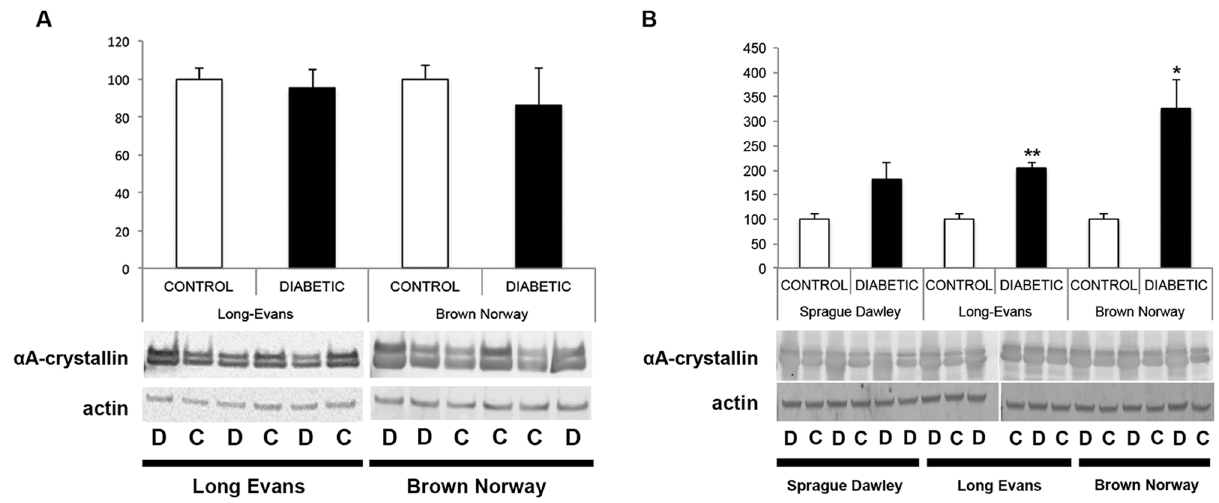
Figure 4. Protein expression analysis of alphaA-crystallin during diabetes. Expression levels were assessed with Western blot analysis using specific antibodies raised against alphaA-crystallin proteins 4 weeks after the onset of diabetes (A) in Long Evans (LE) and Brown Norway (BN) rats. Expression levels were also assessed at 12 weeks (B) in Sprague Dawley (SD), in Long Evans (LE) and Brown Norway (BN) rats. Representative immunoblots and graphic representation of the corresponding quantification of the major bands are presented. C, control; D, diabetic. *Significantly different from control [ P , 0.05].